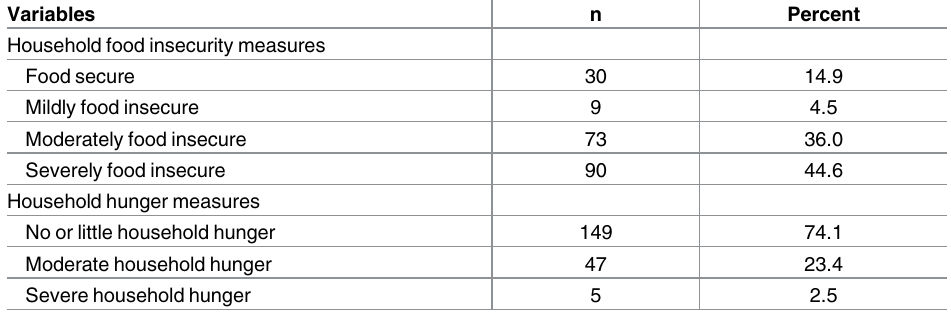
Table 2. Percentage distribution of women by level of household food insecurity and hunger scale (n = 202).